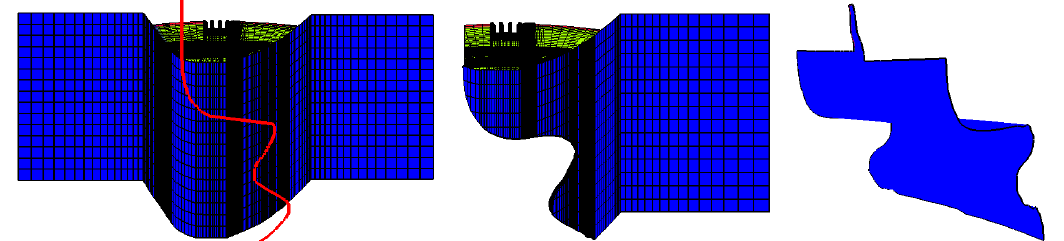
Figure 9. Our free curve cutting result of the dam II.